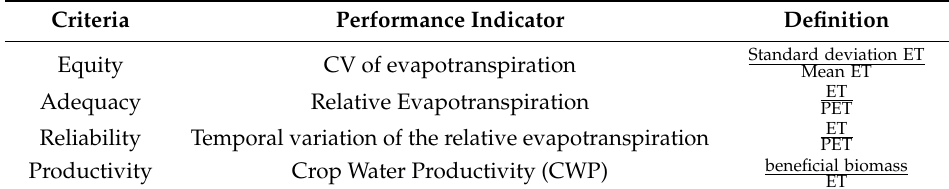
Table 2. Irrigation performance indicators proposed for the study area; selected based on operational activities and resource utilization.